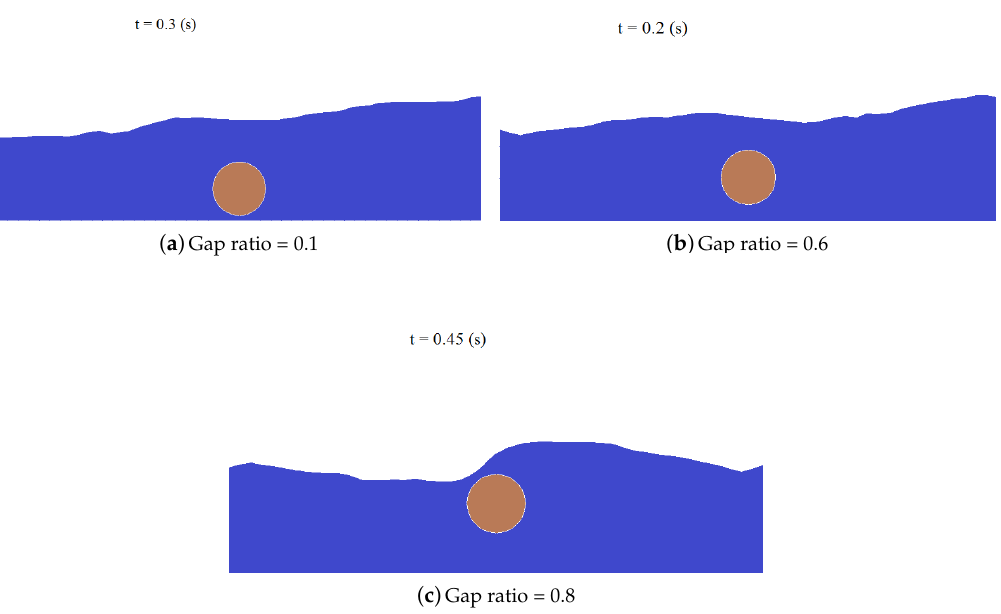
Figure 3. Free surface elevation of the fluid at various distance from the side